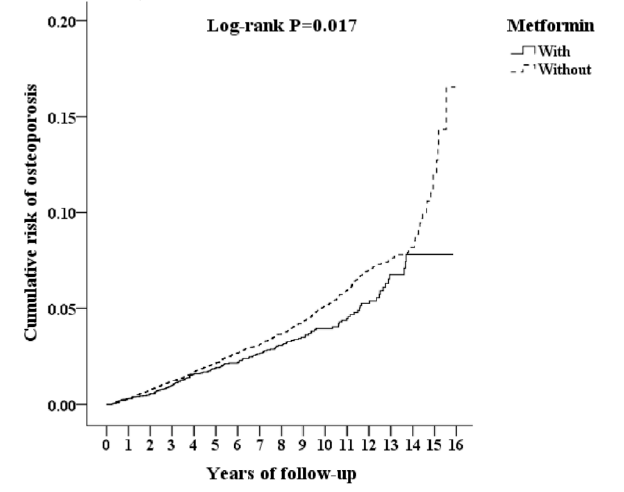
Figure 2. Kaplan-Meier analysis of cumulative risk of osteoporosis among patients with diabetes mellitus with carcinoma in situ aged 18 and over, stratified by metformin use and analyzed using a log-rank test.